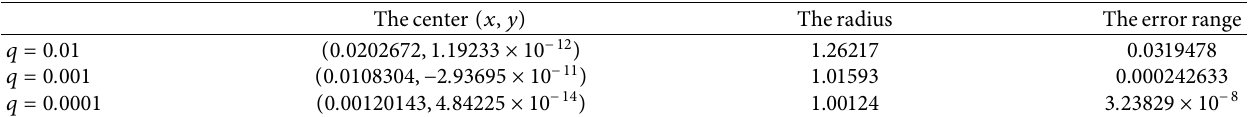
Figure 3: Approximation roots and circles of D ( x ) : (a) q � 0 . 01, (b) q � 0 . 001, and (c) q � 0 . 0001. 50 ,q Table 3: Te circle of approximation roots of D ( x ) 50 ,q